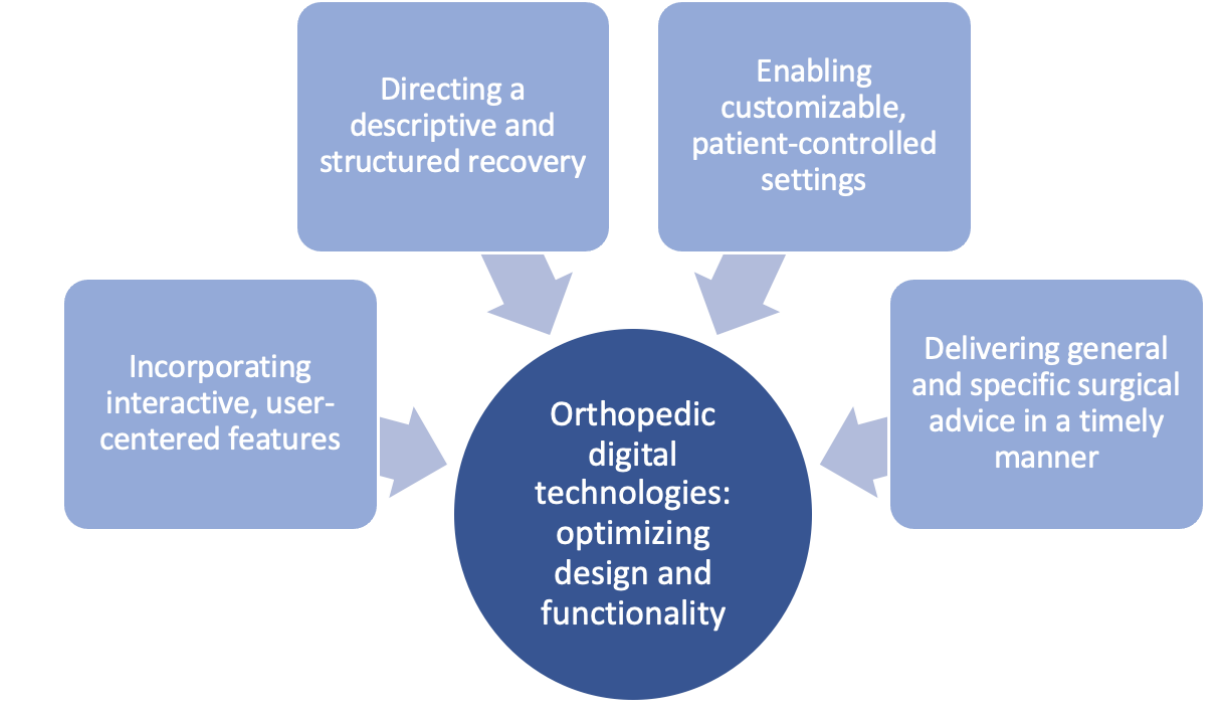
Theme 1: Incorporating Interactive, User-Centered